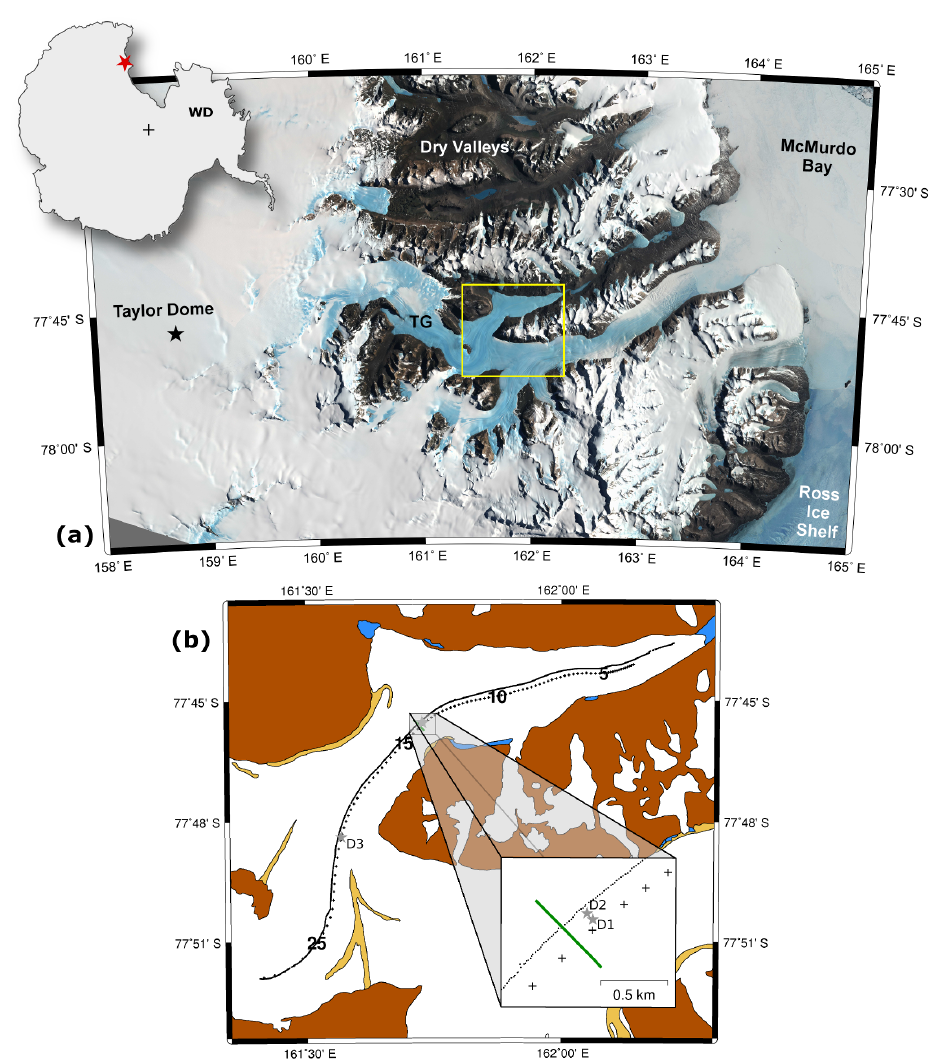
Figure 1. (a) Map of the McMurdo Dry Valleys, with Taylor Glacier (TG) in the center. The Dry Valleys are a series of valleys in the Transantarctic Mountains within Victoria Land (red star). Ice flowing into Taylor Valley originates on the northern flank of Taylor Dome. Satellite imagery courtesy of the US Geological Survey (Bindschadler et al., 2008). (b) More detailed map of the Taylor Glacier ablation zone including the sampling lines. Aciego et al. (2007)’s samples ( · ) and our along-flow profile samples ( + ) are shown. Each symbol represents one sample, but the high sampling resolution causes the Aciego et al. (2007) samples to blend into a solid line, whereas our samples appear as dots. Numbers on the profile denote approximate distance from the glacier terminus in kilometers. The inset shows an enlarged view of the across-flow transect. The solid green line marks the across-flow transect. Gray stars indicate the positions of the three deep cores D1–D3. Ice flow is from the SW to the NE (lower left to upper right). Taylor Glacier receives a small amount of ice from Ferrar Glacier (lower right), with a distinct suture (not shown) separating the two ice